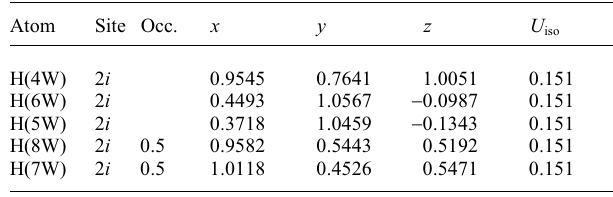
Table 3. Atomic coordinates and displacement parameters (in Å 2 ) . Atom Site